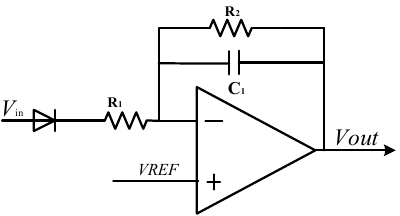
Figure 14. Positive temperature coefficient temperature sensor.